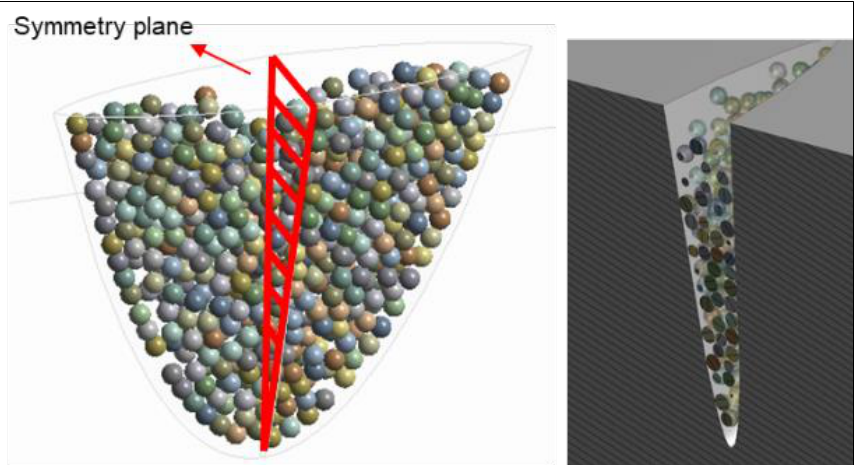
Figure 12. The analyzed cross-section.